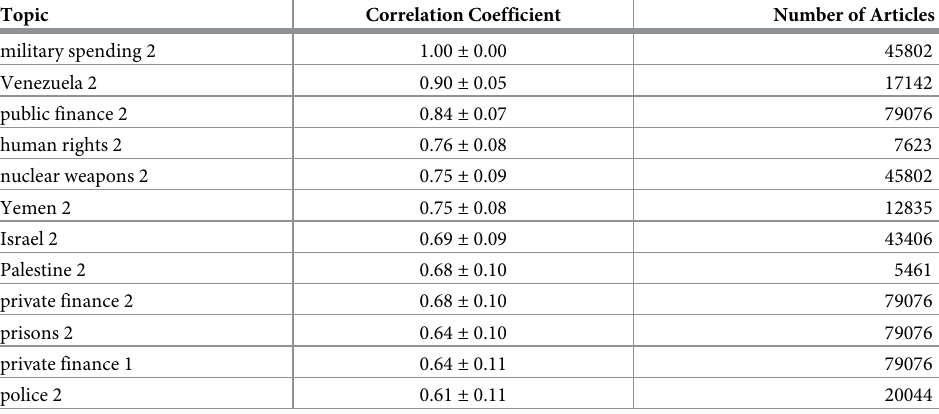
Table 5. Topics whose bias is most correlated with military spending